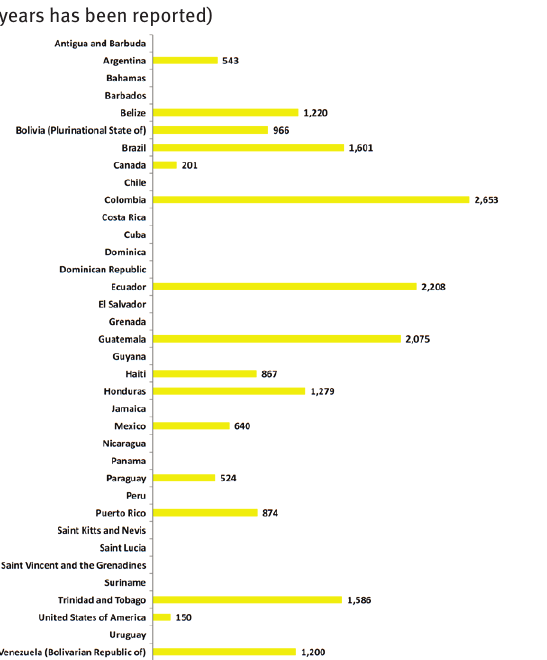
Figure 9: Difference between NRI and irrigation water requirement (mm/yr) in 2011, this index is not available for Antigua and Barbuda, Bahamas, Barbados, Chile, Costa Rica, Cuba, Dominica, Domini- can Republic, El Salvador, Grenada, Guyana, Jamaica, Nicaragua, Panama, Peru, Saint Kitts and Nevis, Saint Lucia, Saint Vincent and the Grenadines, Suriname, Uruguay (in few cases due to lack of data, value of the index in the previous years has been reported)